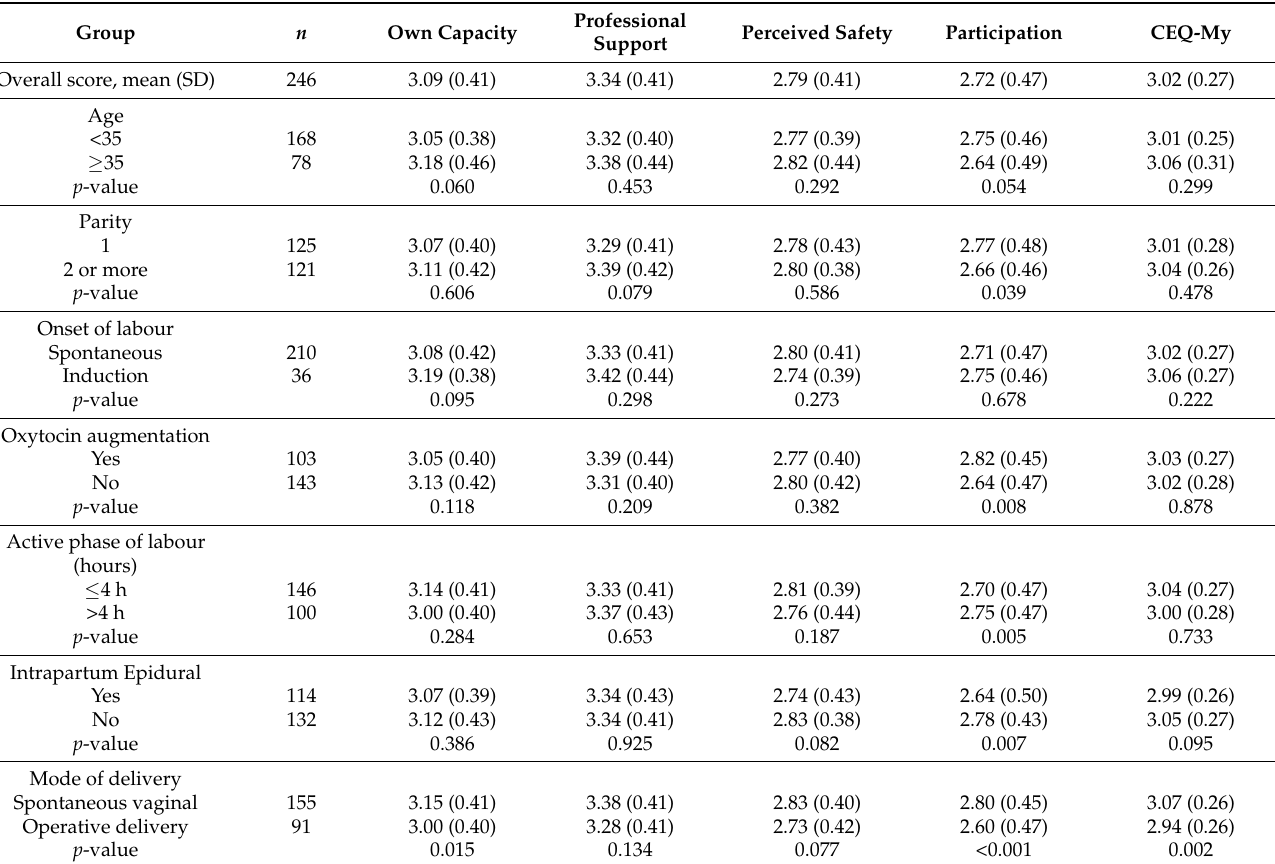
Table 4. Known group